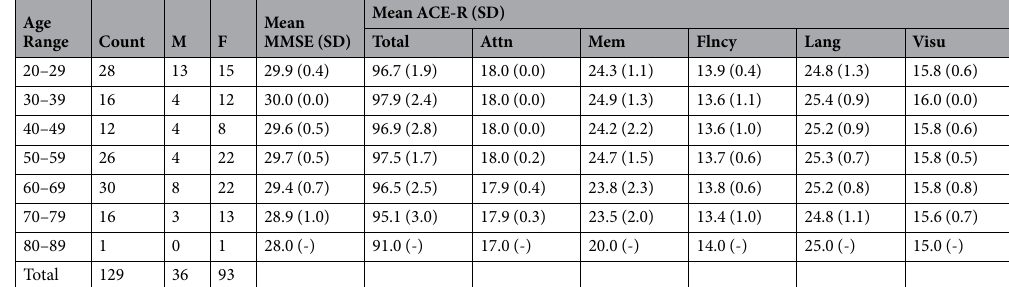
Table 5. Participants’ characteristics. M – male; F – female; MMSE – Mini-Mental State Examination; ACE-R – Addenbrooke’s Cognitive Examination-Revised; Attn – attention; Mem – memory; Flncy – fluency; Lang – language; Visu – visuospatial; SD – standard